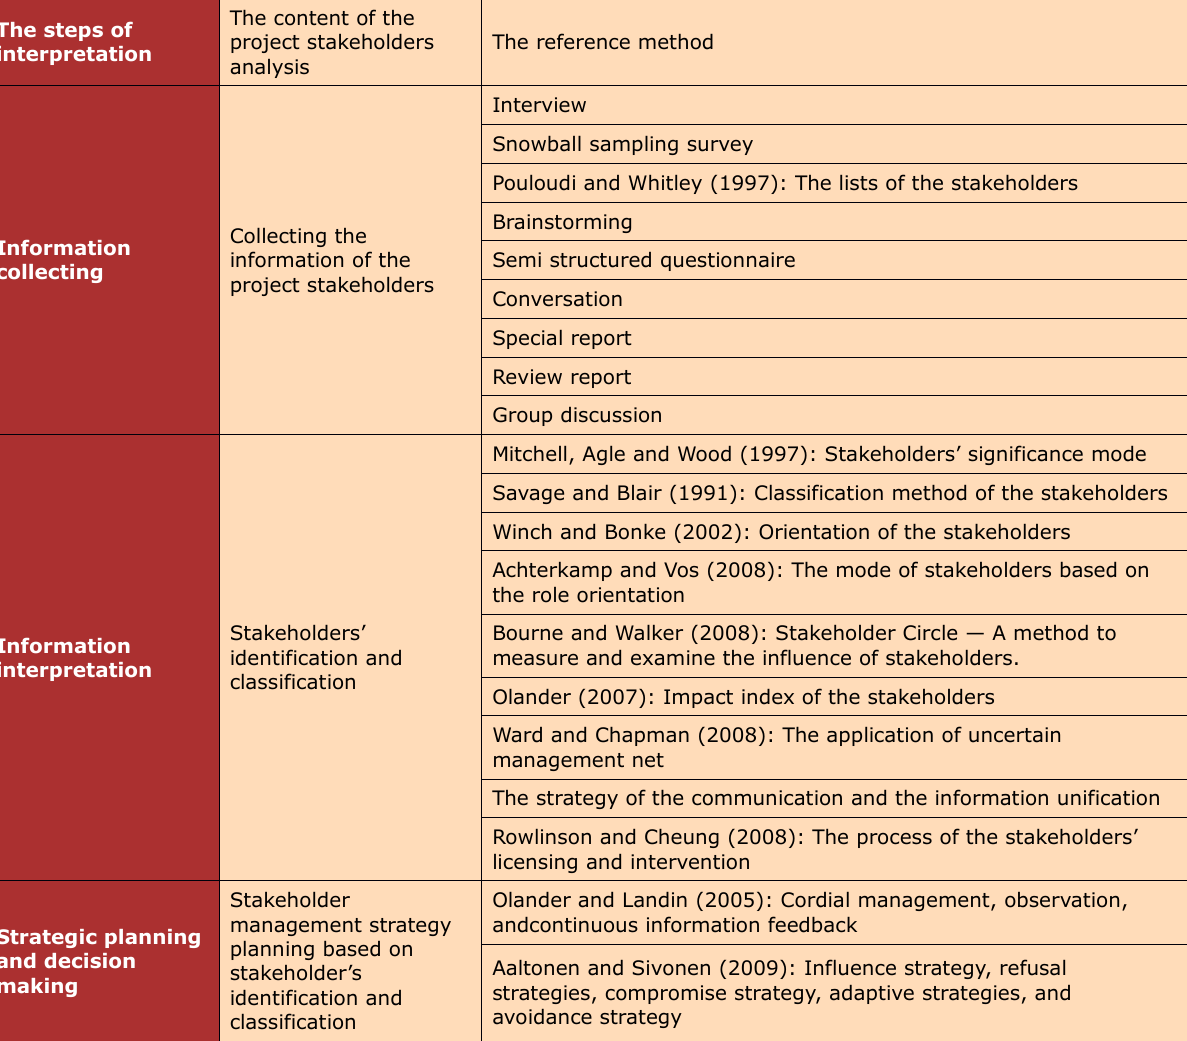
Table 2. The process and the content of the interpretation